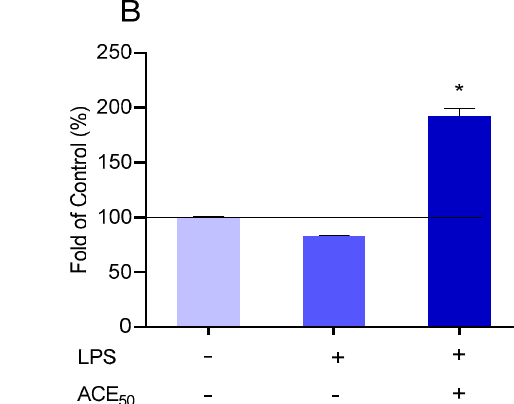
Figure 6. E ff ect of ACE 50 on the level of ROS ( A ). * indicates the significant increase of ROS in lipopolysaccharide (LPS)-induced inflammation compared to the control. # indicates the significant changes in ROS in LPS-induced inflammation and ACE 50 treatment compared to the level of ROS in LPS-induced inflammation without ACE 50 . E ff ect of ACE 50 on the level of GSH ( B ). * indicates the significant increase of GSH after ACE 50 treatment in LPS-induced inflammation compared to the control. Results are expressed in the percentage of the control (100% is represented by the solid lines). Data are expressed as the mean ± SEM of four individual experiments. ACE 50 , 50 μ g/mL anthocyanin extract.